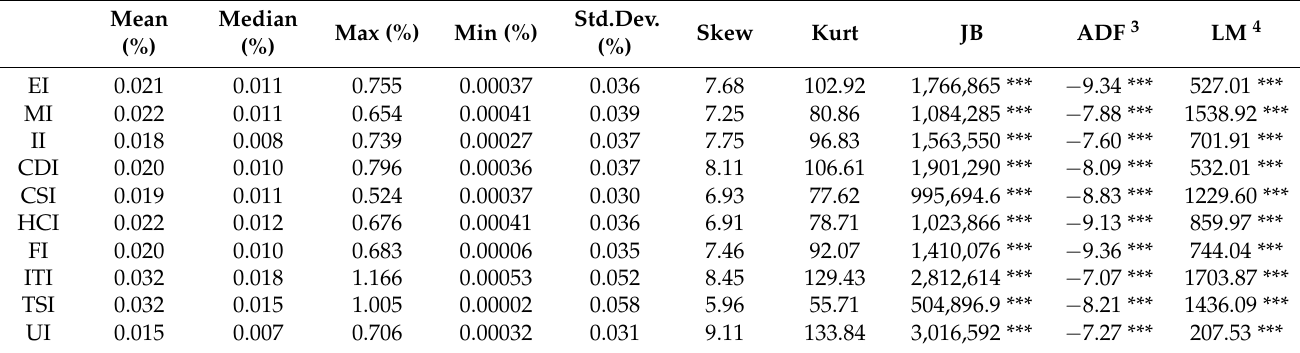
Table 2. Descriptive statistics of 10 sector indices’ volatility 2